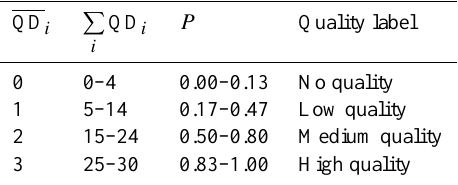
Table 1. Quality label per